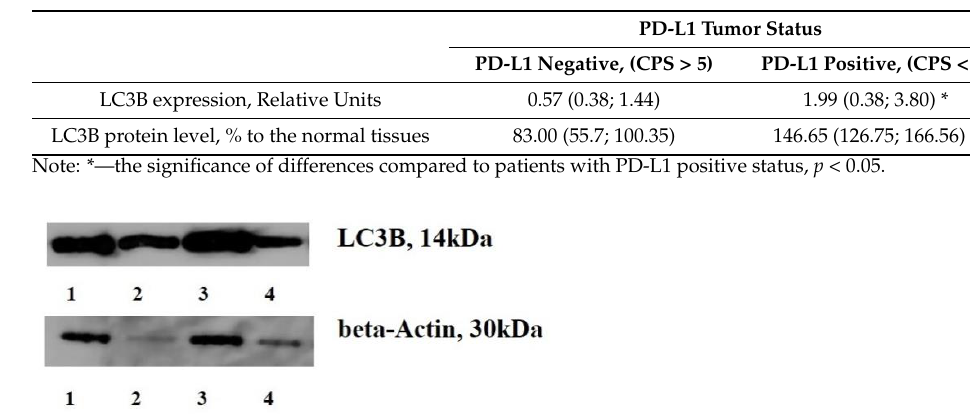
Table 3. Expression of LC3B, mTOR, AMPK, and autophagosome LC3B protein content in gastric tumor tissue depending on PD-L1 tumor status.